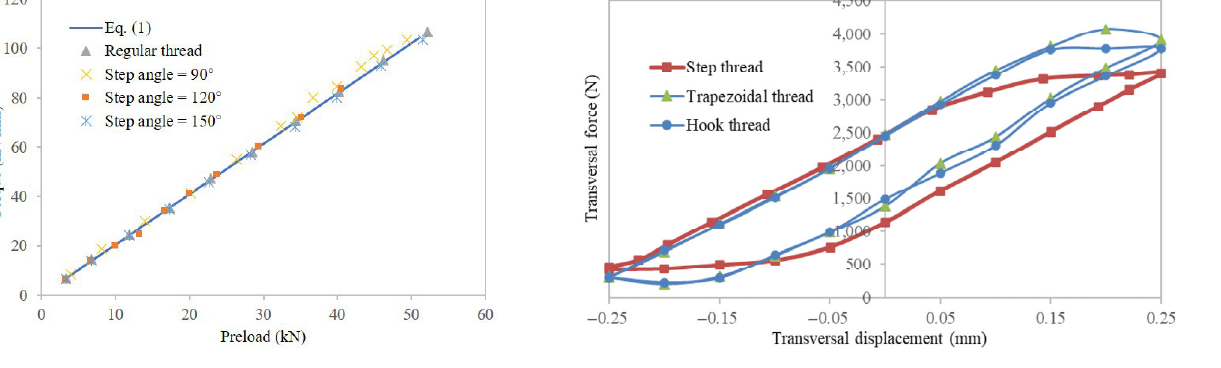
Fig. 15 Comparison of torque–tension relationships by FEM with Eq. (1).